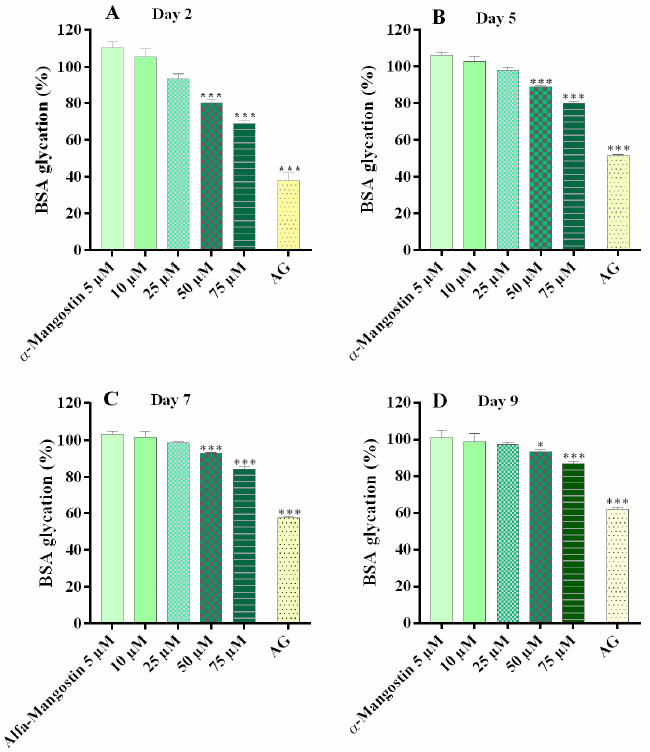
Figure 2. Inhibition of α -mangostin on AGE formation after 2 ( A ), 5 ( B ), 7 ( C ), and 9 ( D ) days